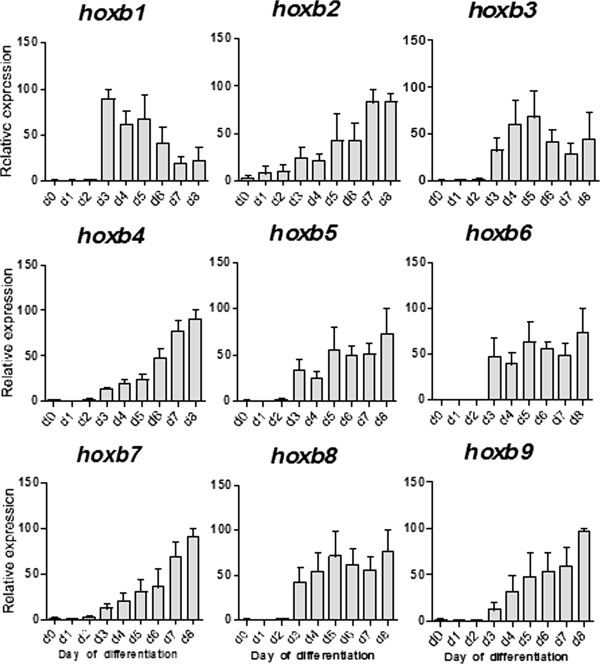
The timing of Hoxb gene expression in mouse embryonic stem cells following induction of differentiation. Mouse embryonic stem (ES) cells (CCE/R) were induced to differentiate by removal of the growth factor leukaemia inhibitory factor (LIF) and replating at day 0, followed by addition of retinoic acid (RA, 1 μM) at day 2. RNA and cDNA were prepared from cell pellets at day 0 and daily thereafter and transcript levels from individual Hoxb genes (Hoxb 1 to 9) were determined by real time-quantitative (RT-q)PCR. At each timepoint, expression was calculated as a percentage of the highest value in the untreated sample. Error bars represent the standard error of the mean of independent experiments (n = 3).